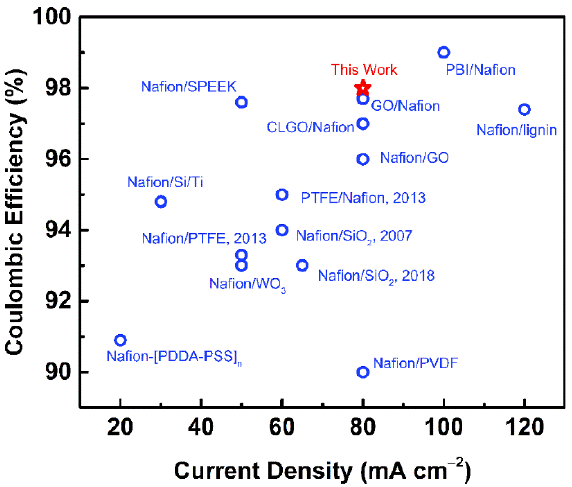
Figure 5. Cell performances employing Nafion and 60PTFE@Nafion membranes at 80 mA cm –2 . ( a ) Charge–discharge curves, ( b ) self-discharge curves under 75% SOC, ( c ) coulombic, voltage, and energy efficiencies, and ( d ) discharge capacity retention.